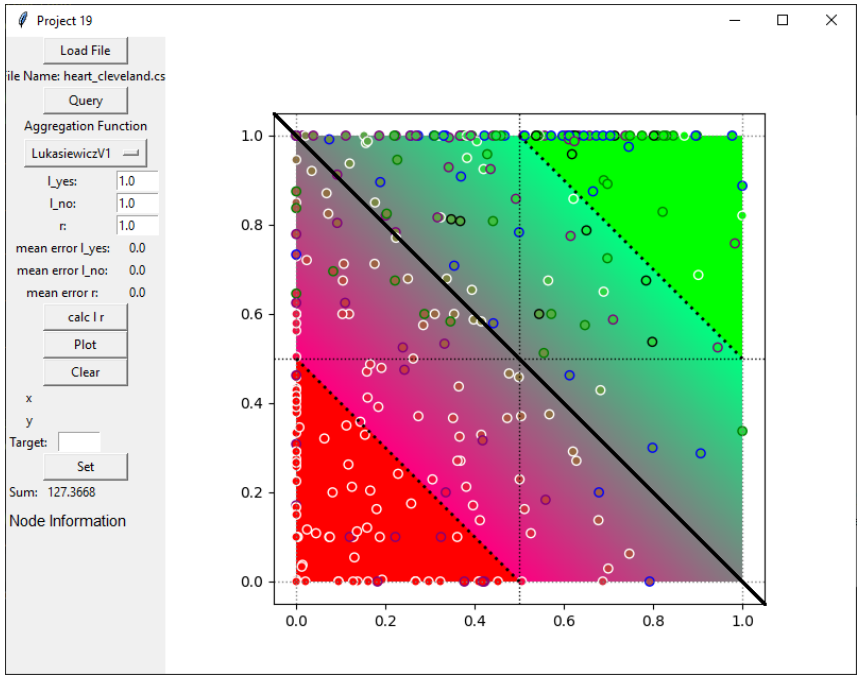
Figure 16. Separation of the classification space for parameter fitting. The dataset from Section 6.1 is loaded in order to visualise the distribution of the points relative to the